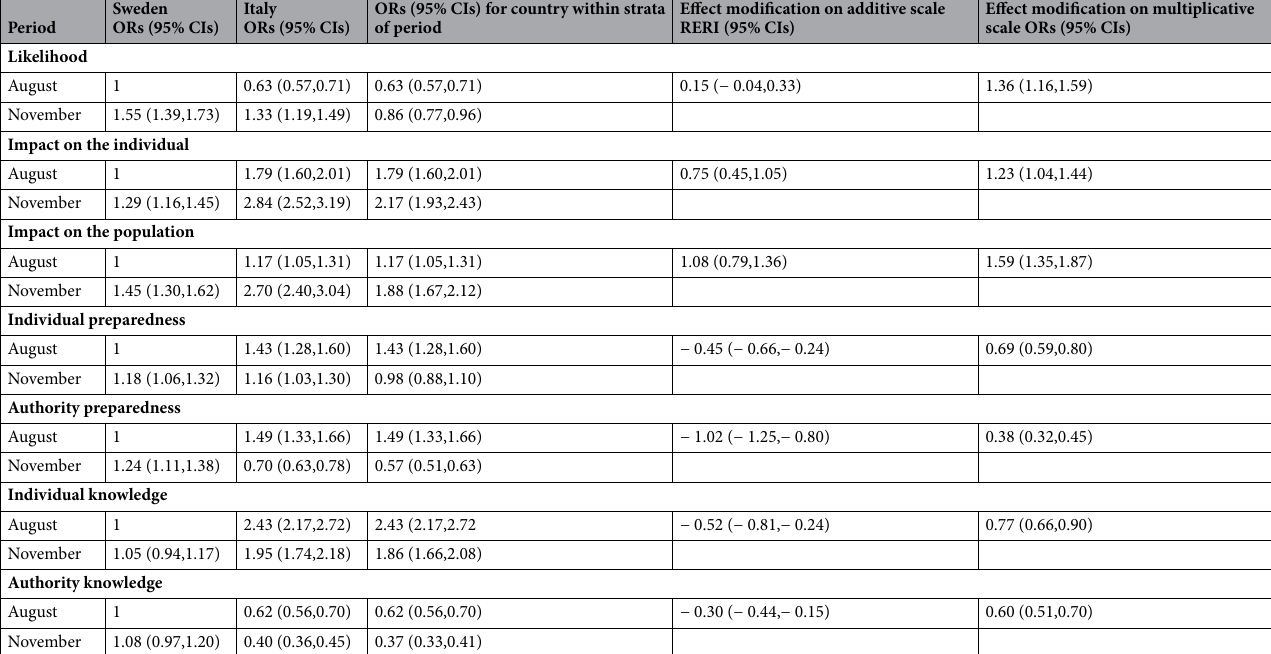
Table 1. Country (Italy vs. Sweden) effect modification on the association between period and pandemic risk